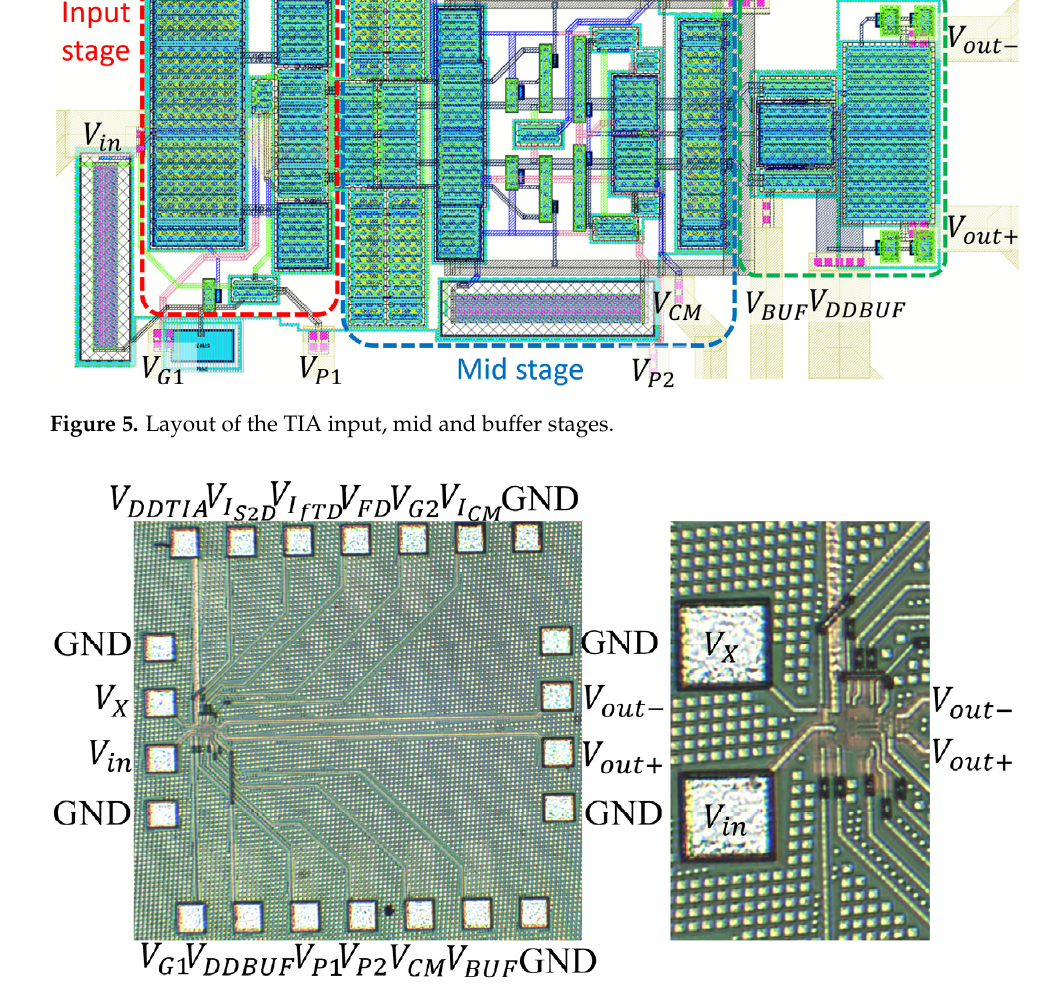
Figure 6. Die microphotographs of different magnifications of the TIA. Table 1. Bias settings for all DC pads for the TIA design and for the various gain and peaking settings. Bias Settings for All DC Pads